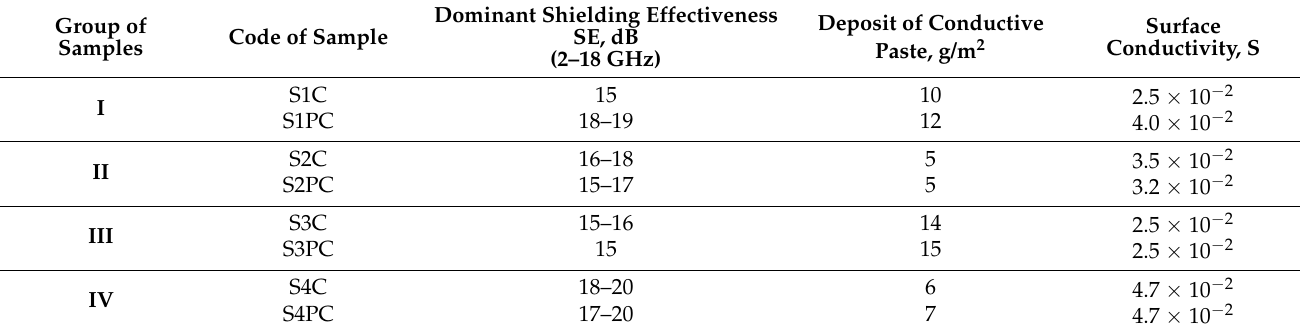
Table 5. EMR shielding effectiveness of investigated